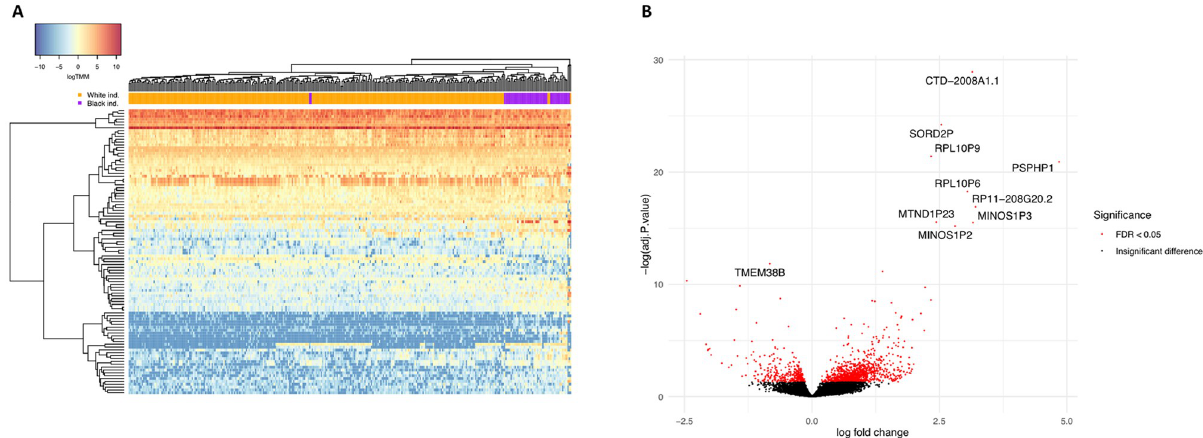
Fig 2. DEGs between Black and White individuals in the tibial artery. (A) Expression heatmap of the top 100 DEGs in 336 tibial artery tissue samples, showing the result of a two-way unsupervised hierarchical clustering. Each row represents a DEG and each column represents a sample. The order of genes and samples was determined in an unsupervised manner, based on similarities in expression profiles, and is detailed in S4 Table. Samples are color coded according to their reported race. Expression values are presented in log(TMM), scaled according to the color key in the top left corner. (B) Volcano plot depicting the magnitude and significance of expression differences at the single gene level. For each gene expressed in the tibial artery, the log 2 fold change of normalized expression between Black and White individuals is shown on the X axis, and the negative log 10 of its FDR-adjusted P value is shown on the Y axis. Positive X values represent upregulation in Black individuals and negative X values represent downregulation. Significant DEGs are in red and the symbols of the 10 most significant ones are noted. DEG, differentially expressed gene.